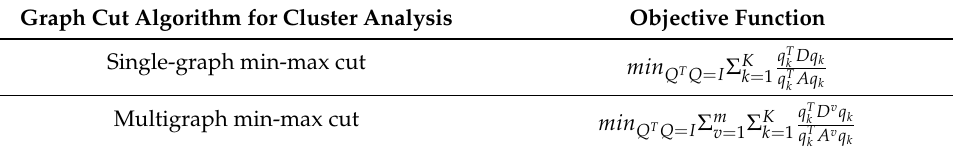
Table 2. Objective functions of single-graph and multigraph clustering. A is the adjacency matrix, which is equivalent to the similarity network in this study. D is the diagonal matrix of A. Q is the output clustering labels. K is the number of